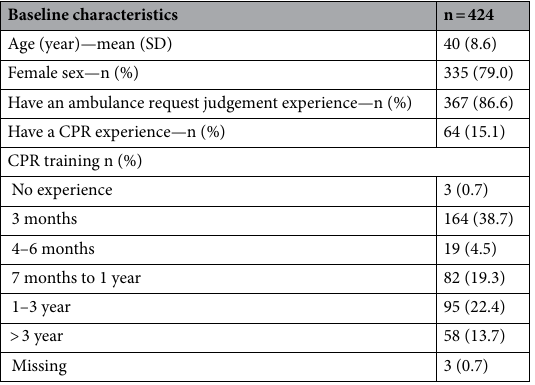
Table 1. Baseline characteristics of the participants. CPR Cardiopulmonary